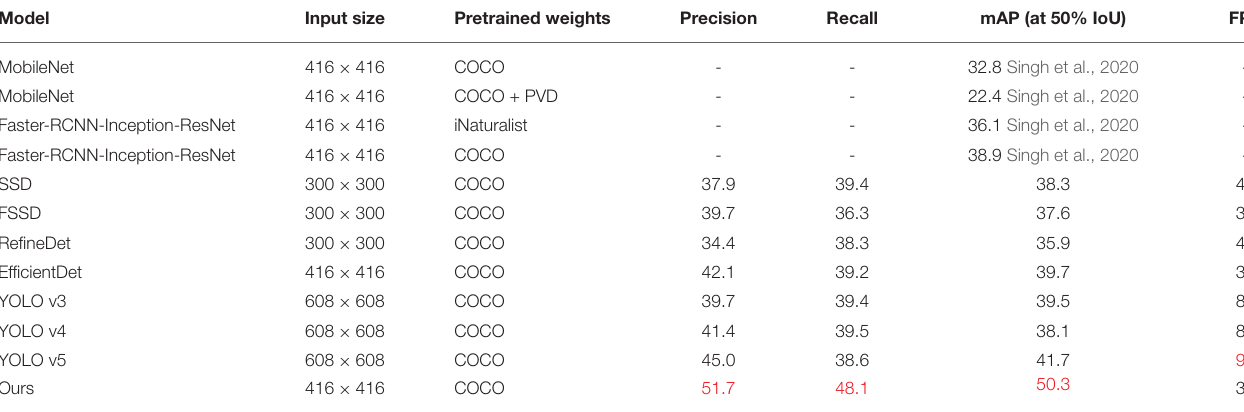
TABLE 1 | Comparisons of different detection networks’ performance (in